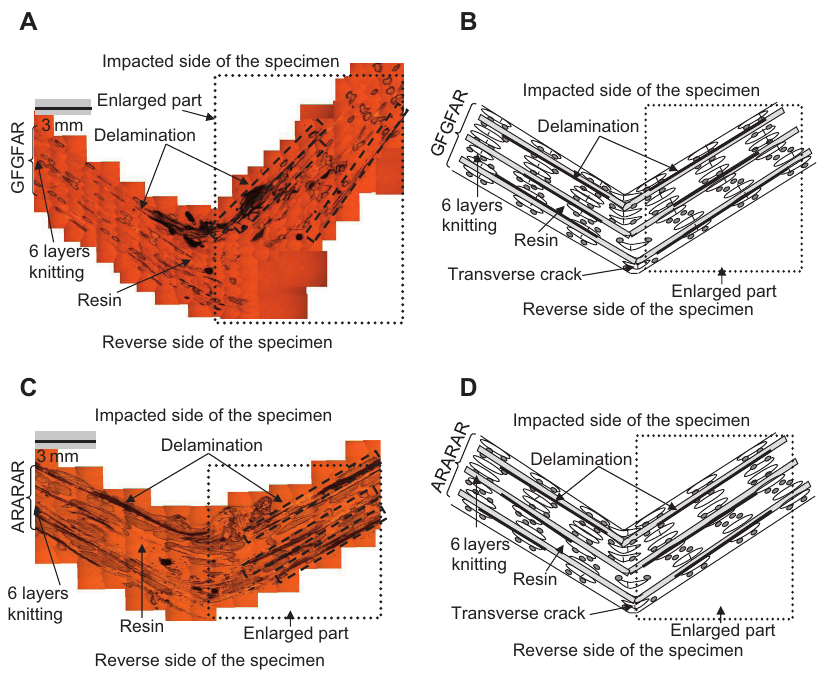
Figure 8 Cross-sectional photographs of the specimens after the three-point bending impact test and schematic drawings: (A, B) GF-GF-AR and (C, D)